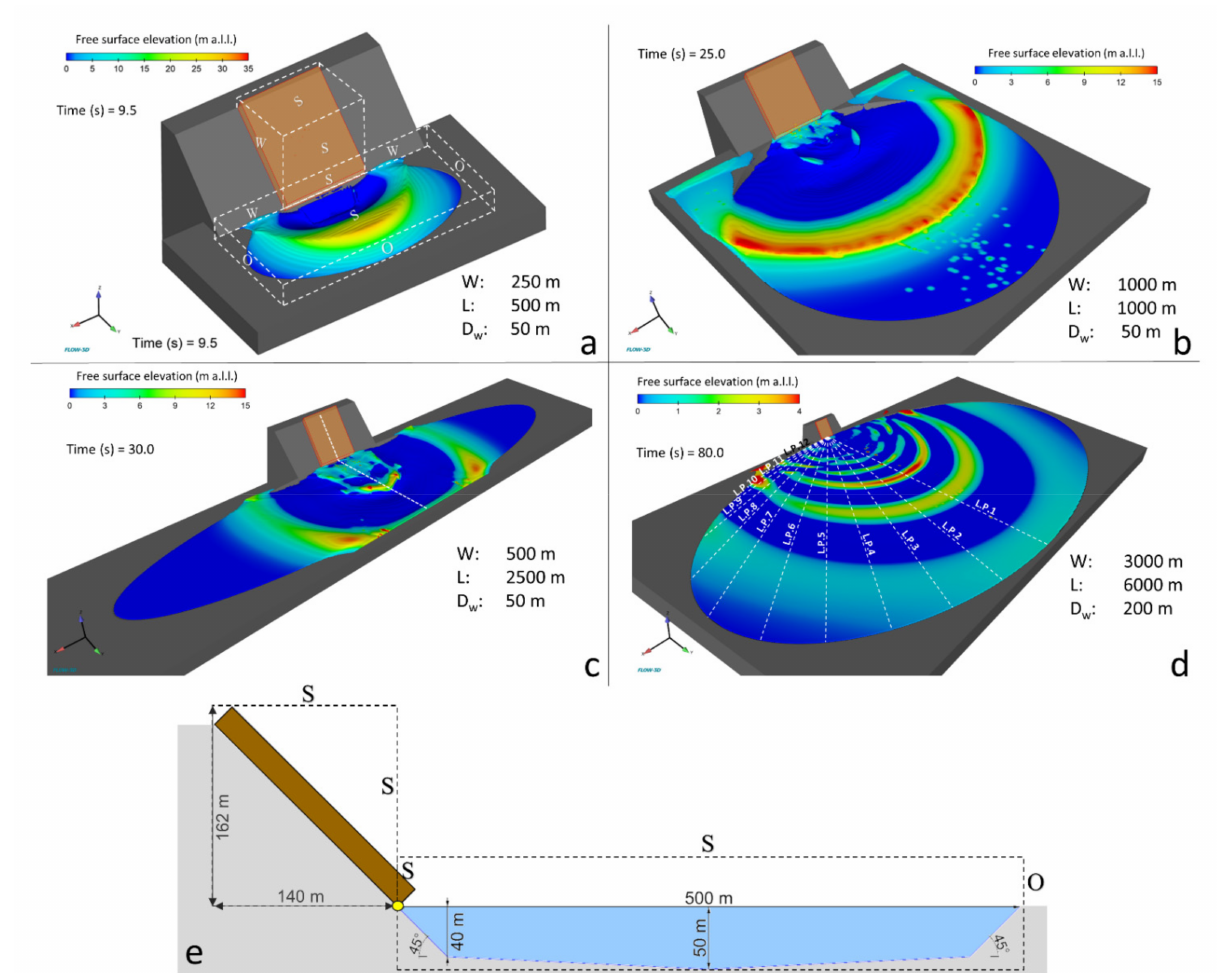
Figure 4. Examples of theoretical lakes and model set-ups showing simulations of a landslide-induced impulse wave. ( a ) Small elongated medium-size lake; in this example, the boundary conditions are shown (S-symmetry; W—wall; O—outflow). ( b ) Equidimensional medium-size lake. ( c ) Narrow elongated medium-size lake. ( d ) Elongated large-size lake (dotted white lines represent lines probes (L.P. 1–12) used to record water-surface elevations in FlowSight). ( e ) Example of longitudinal section for the theoretical lake in ( c ) along the slide direction (dotted white line); boundary conditions are shown. The yellow dot represents the origin of the system in the model